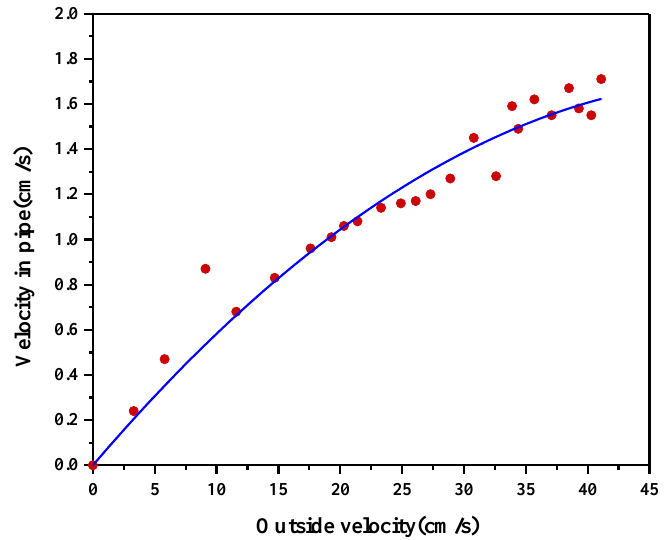
Figure 8. Correlation between internal and external flow rates.